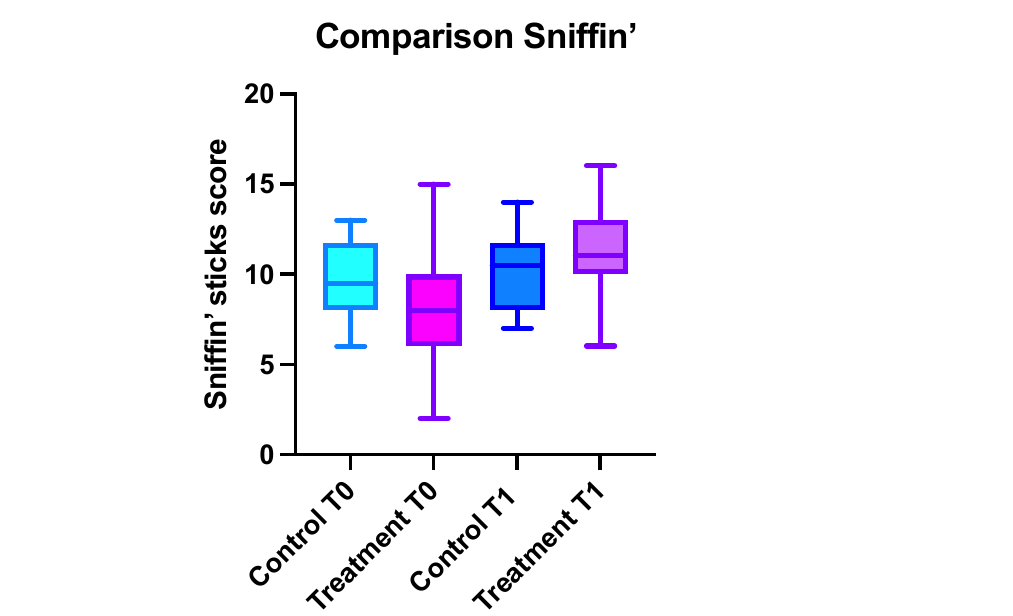
Figure 3. Comparison between the patients who recovered from parosmia in treatment group and in control group; the di ff erence was not statistically signi fi cant ( χ : p = 0.3). The multilinear regression analysis showed that in the treatment group the score of the Sni ffi n’ score at T1 were not correlated to the resolution of the parosmia ( p = 0.06), while in the control this was related to the age ( p = 0.0007) and the Sni ffi n’score at T0 ( p = 0.02). 4. Discussion This prospective randomized controlled trial con fi rmed the e ffi cacy of combination between olfactory training and umPEA-LUT as treatment of quantitative post COVID smell disorders; the e ffi cacy of the treatment on qualitative smell disorders should be deeply investigated because several co-factors other than the Sni ff n’scores can impact on the persistence or resolution of parosmia after treatment. Based on the hypothesis that quantitative smell disorders could be related to the in- fl ammation in the olfactory bulbs, while qualitative disorders might be caused by the damage of neuro-epithelium [5] the absence of statistically signi fi cant di ff erence regard- ing the recovery from parosmia that we observed was totally predictable. On the other hand, Di Stadio et al. speculated that the use of umPEA-LUT might help even in case of